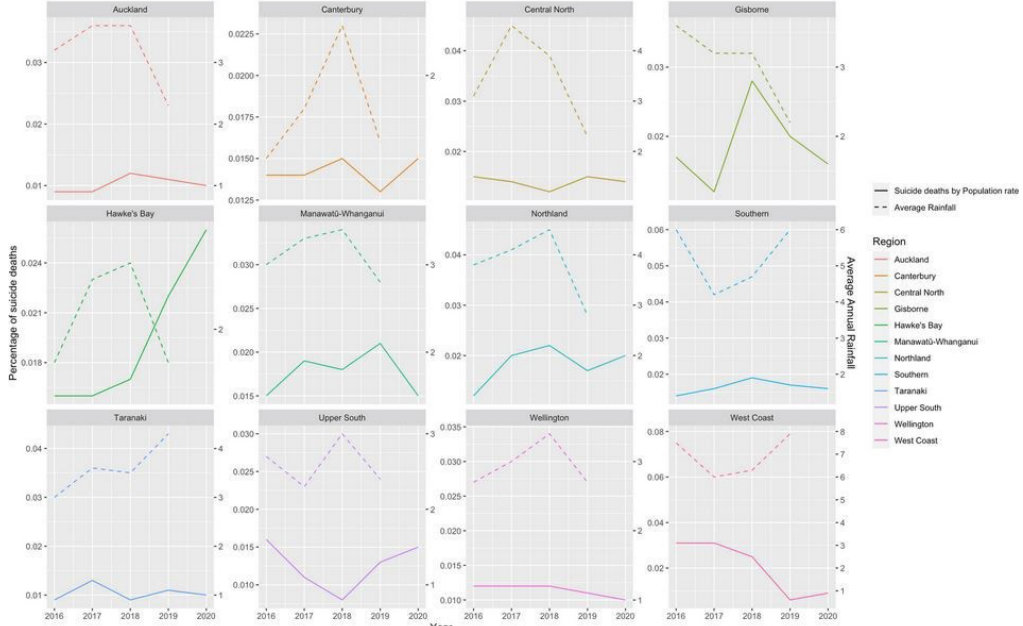
Figure 4. Annual rainfall compared to the percentage of deaths by suicide